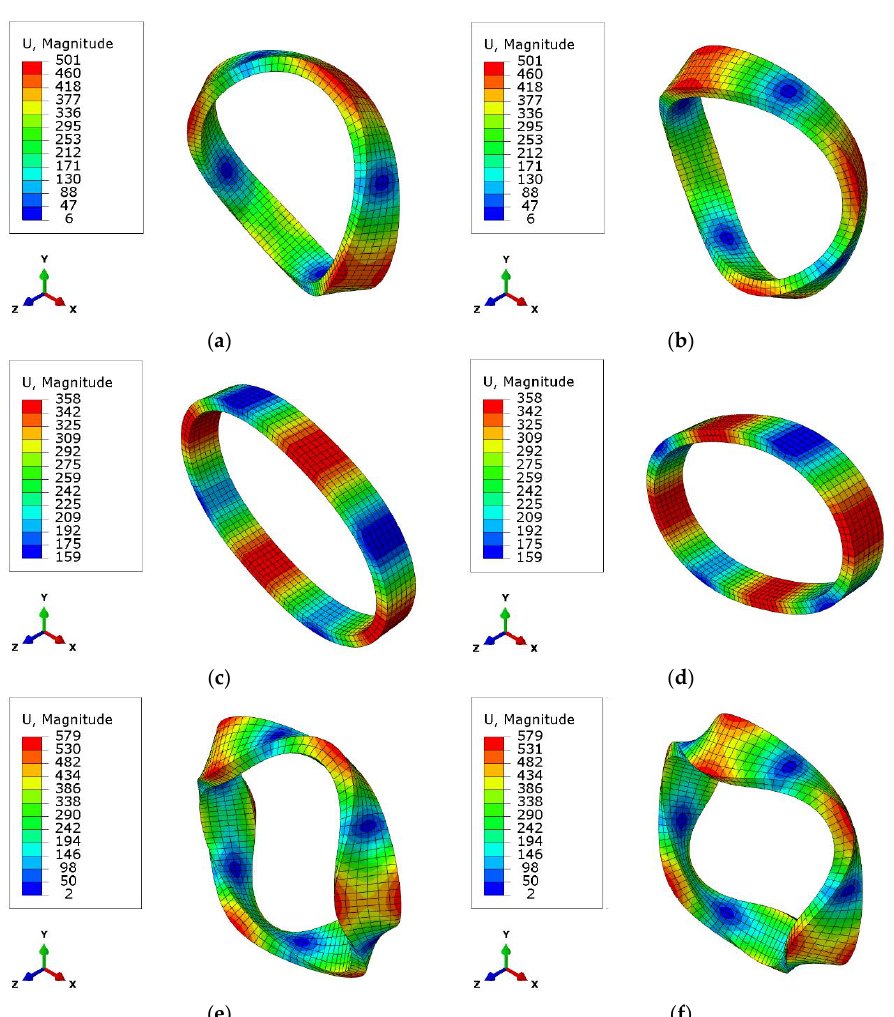
Figure 19. Mode shapes for the coil Type-2: ( a , b ) first mode shape; ( c , d ) second mode shape; ( e , f ) third mode shape.